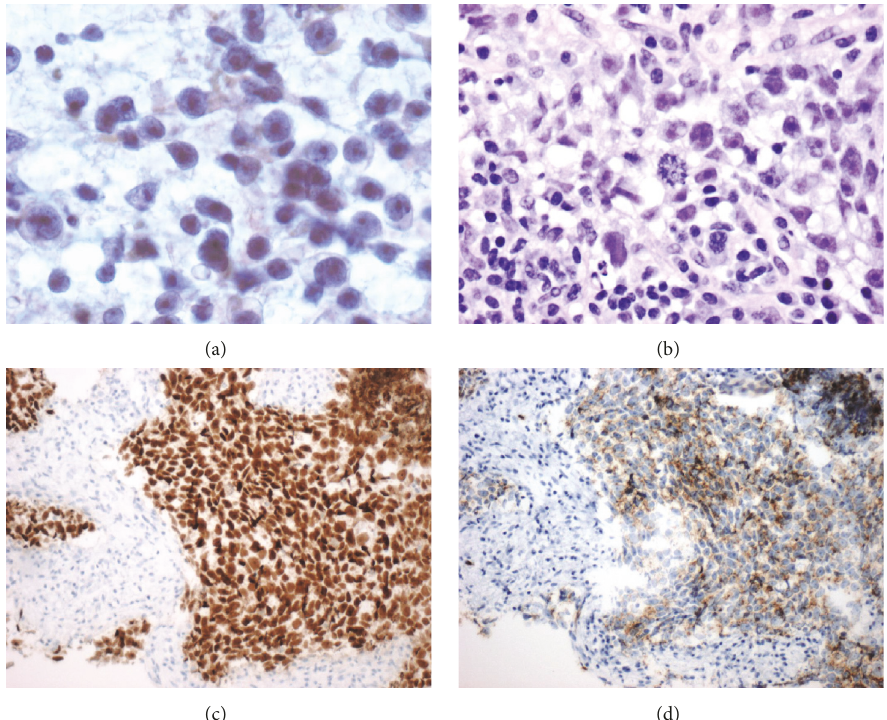
Figure 3: FNA smears and core biopsy of abdominal mass. Malignant cells with high nuclear to cytoplasmic ratio, pleomorphic nuclei, and macronucleoli, singly and in loose clusters, in a background of small lymphocytes (Papanicolaou stain, × 400) (a); core biopsy section shows similar tumor cells (H&E stain, × 400) (b); tumor cells show immunoreactivity to Oct-3/4 (c) and c-kit